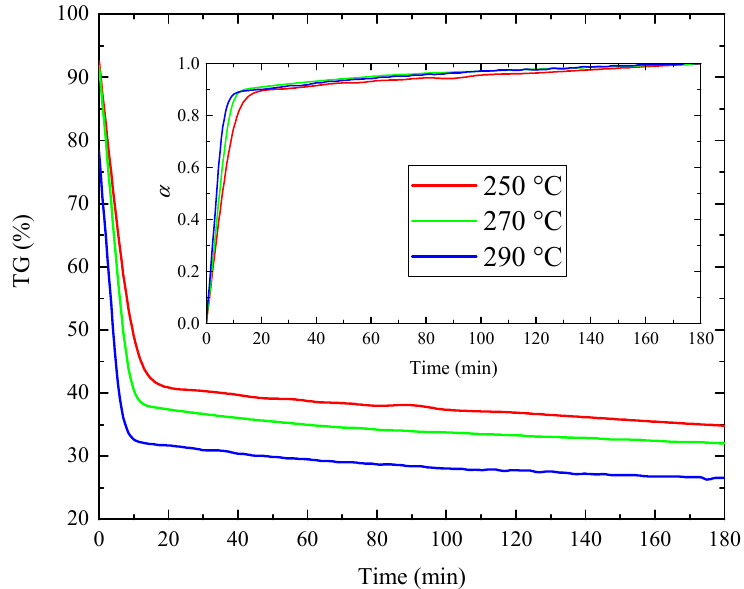
Figure 4. Results of TG analysis under isothermal heating. Inserted graph: dependence of the conversion degree on the time.